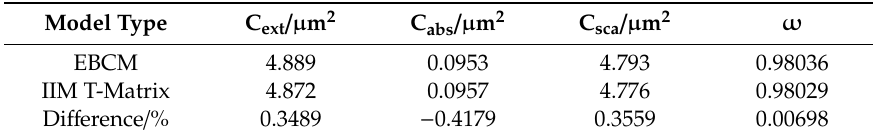
Table 1. The integral scattering parameters calculated by the IIM and EBCM T-Matrix methods for the small spheroidal